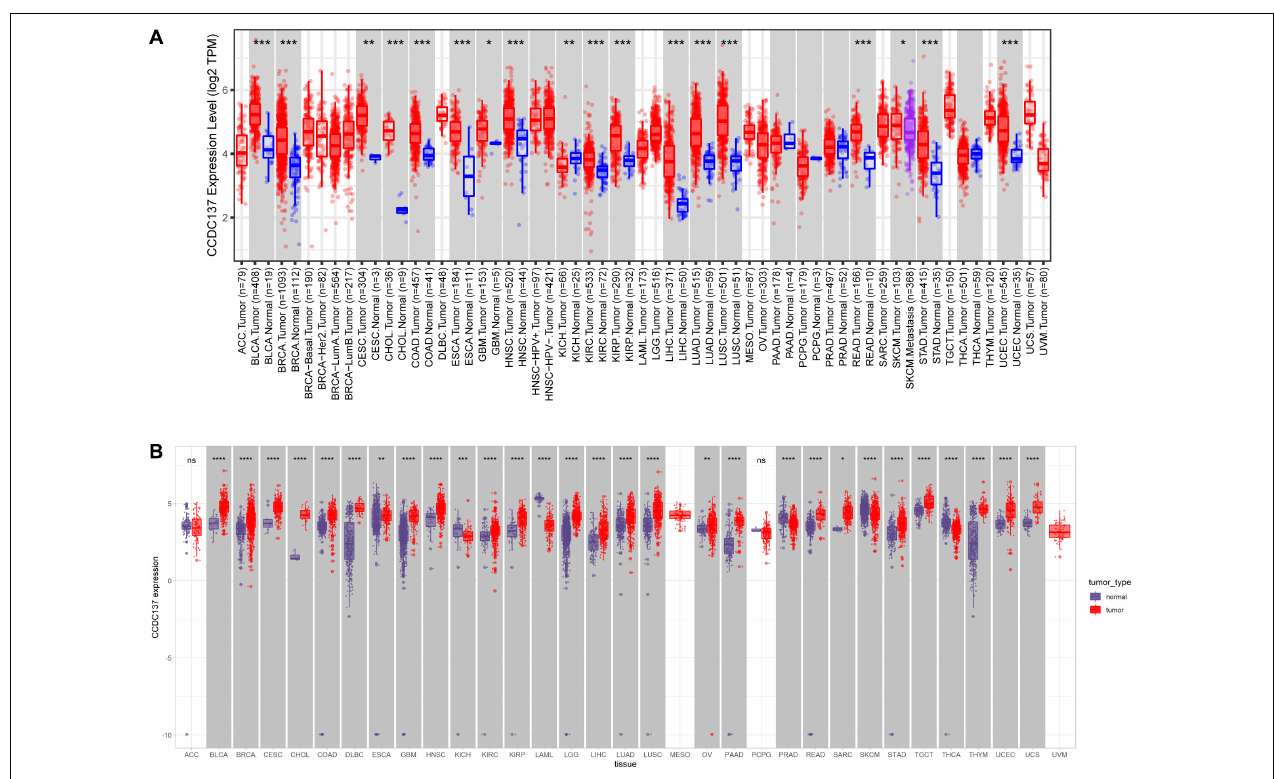
FIGURE 1 | Pan-cancer CCDC137 expression analysis. (A) CCDC137 expression in tumor and adjacent normal tissues in pan-cancer data of TCGA cohort. (B) CCDC137 expression in tumor tissues from TCGA and normal tissues from TCGA and GTEx cohorts. Data shown as mean ± SD. * p < 0.05, ** p < 0.01, *** p < 0.001, and **** p <